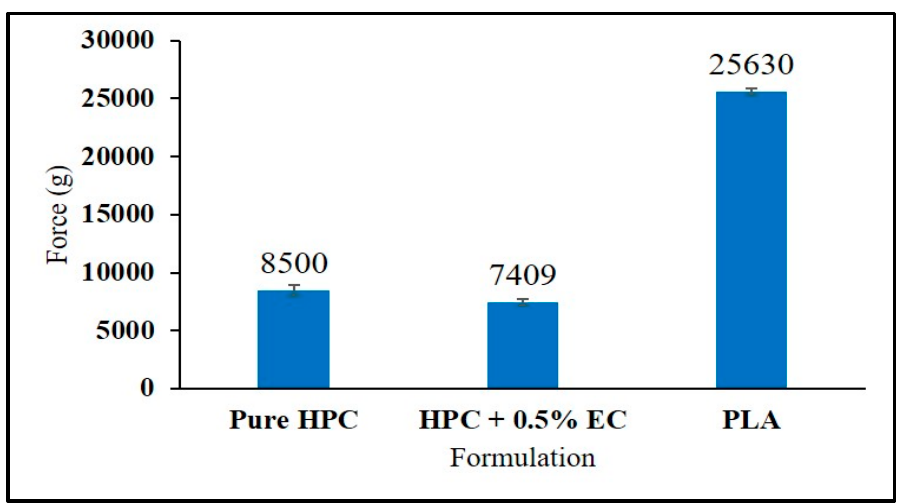
Figure 3. Force values of stiffness test of the hot-melt extruded filaments (error bars represent mean ± S.D).